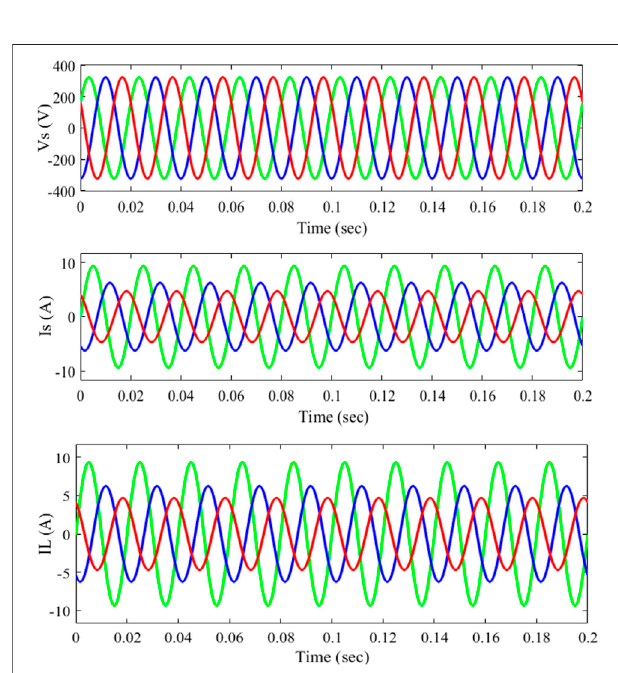
FIGURE 15 | Total harmonic distortion with the passive fi lter.